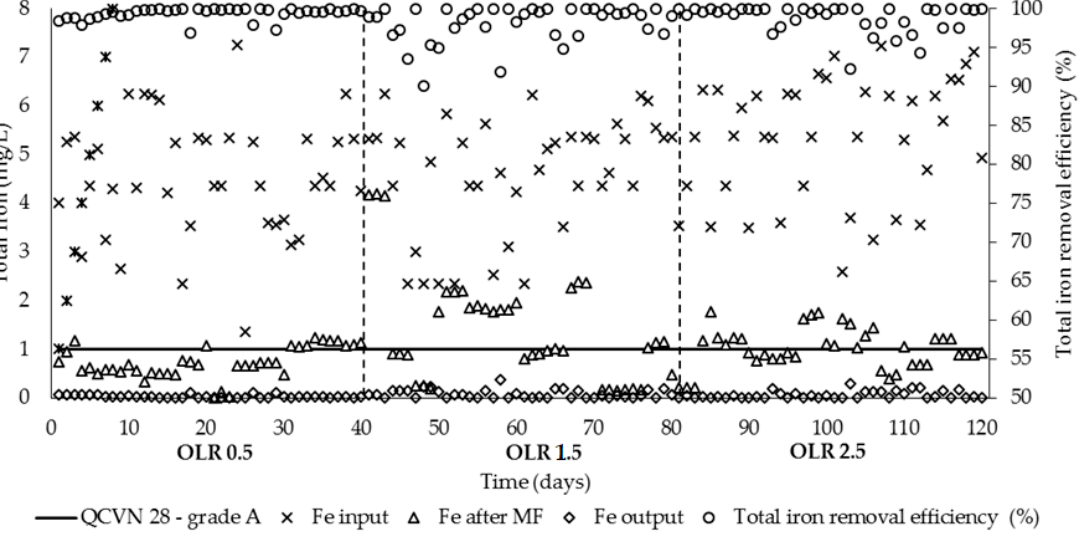
Figure 6. Total iron removal efficiency at three organic load rates in a duration of 120 days of the MBR-nano system.